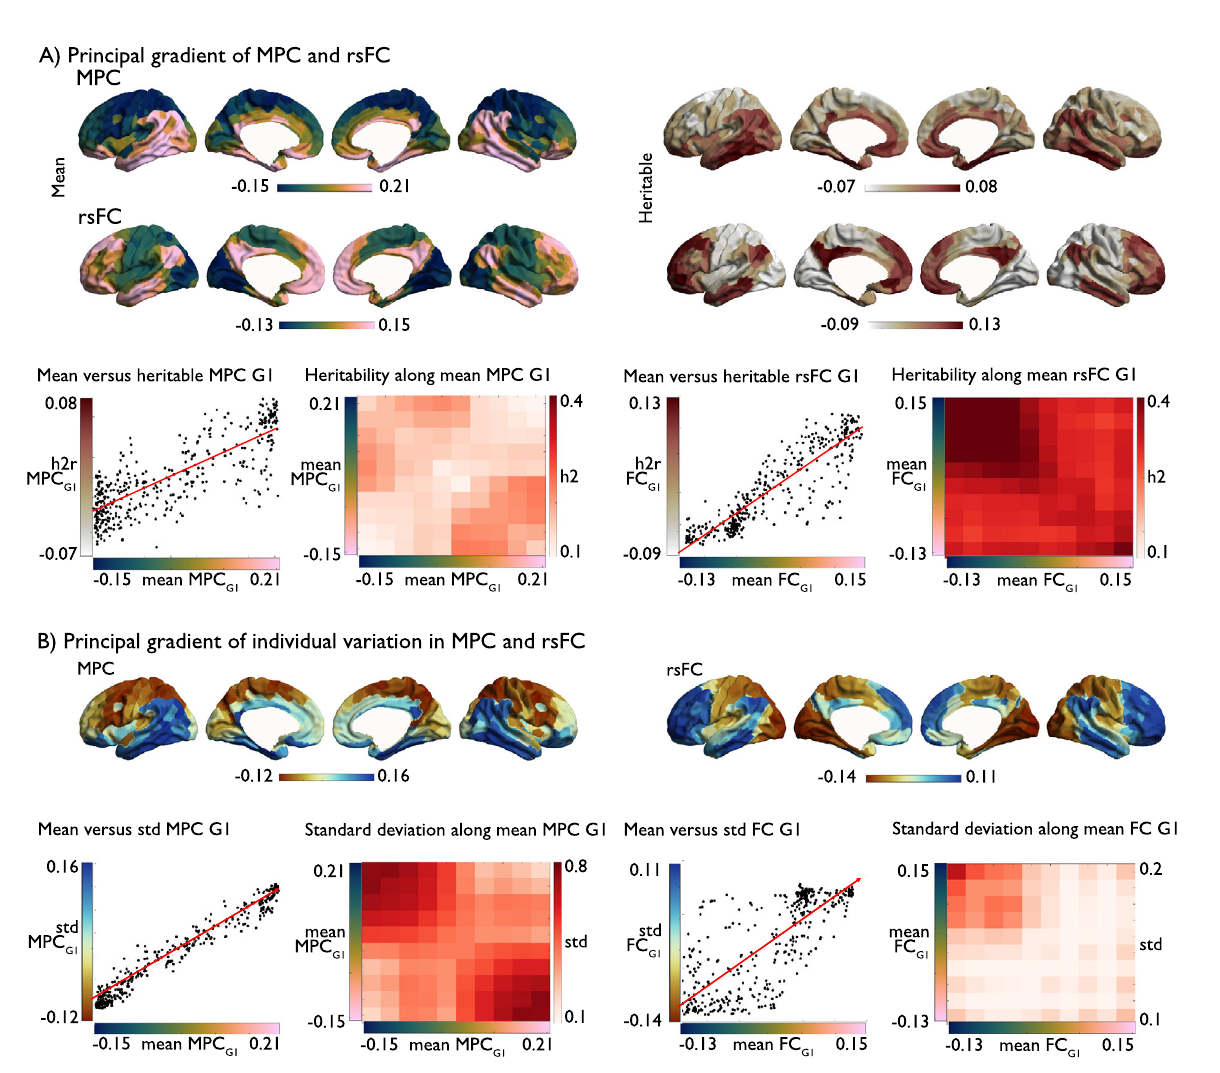
Fig. 5 Principal gradient of heritability and individual variability. A Principal gradient of MPC and rsFC, left: gradients based on mean data on MPC and rsFC and right gradients of heritable data alone, lower left panel: mean versus heritable MPC G1, as well as heritably along the principal mean gradient in MPC; lower right panel: mean versus heritable rsFC G1, as well as heritably along the principal mean gradient in rsFC; B Principal gradient of individual variation (std) in MPC and rsFC, lower panel left: correlation between mean and std MPC G1, and std along the mean gradient of MPC; lower panel right: correlation between mean and std rsFC G1, and std along the mean gradient of FC. Source data are provided as a Source Data fi